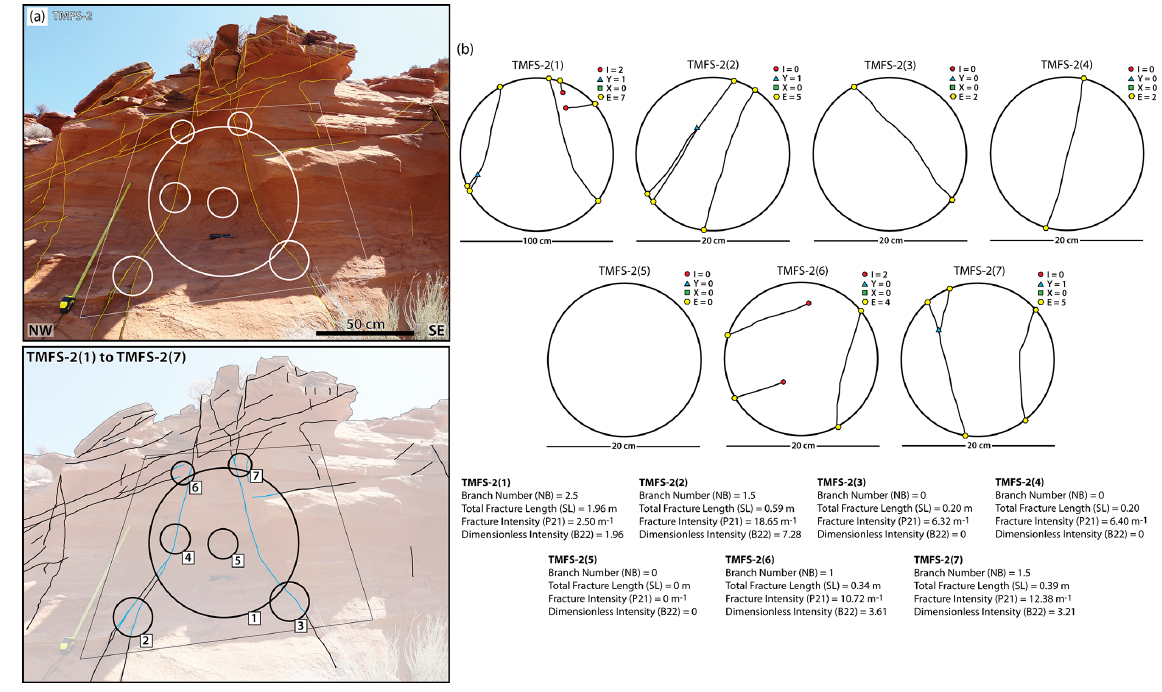
Figure A2. Sample station TMFS-2 scan circles (a) and nodal analysis (b) with statistics.